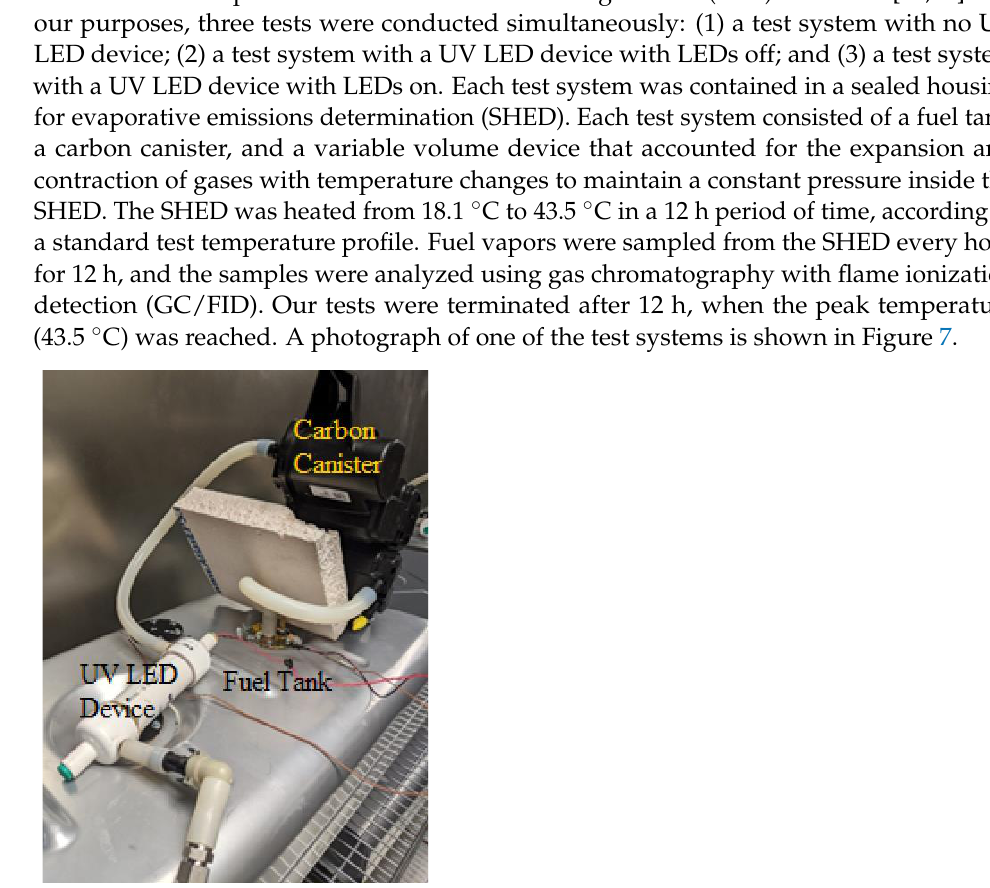
Figure 7. Photograph of test apparatus within a SHED during standard testing for evaporative fuel vapor emission